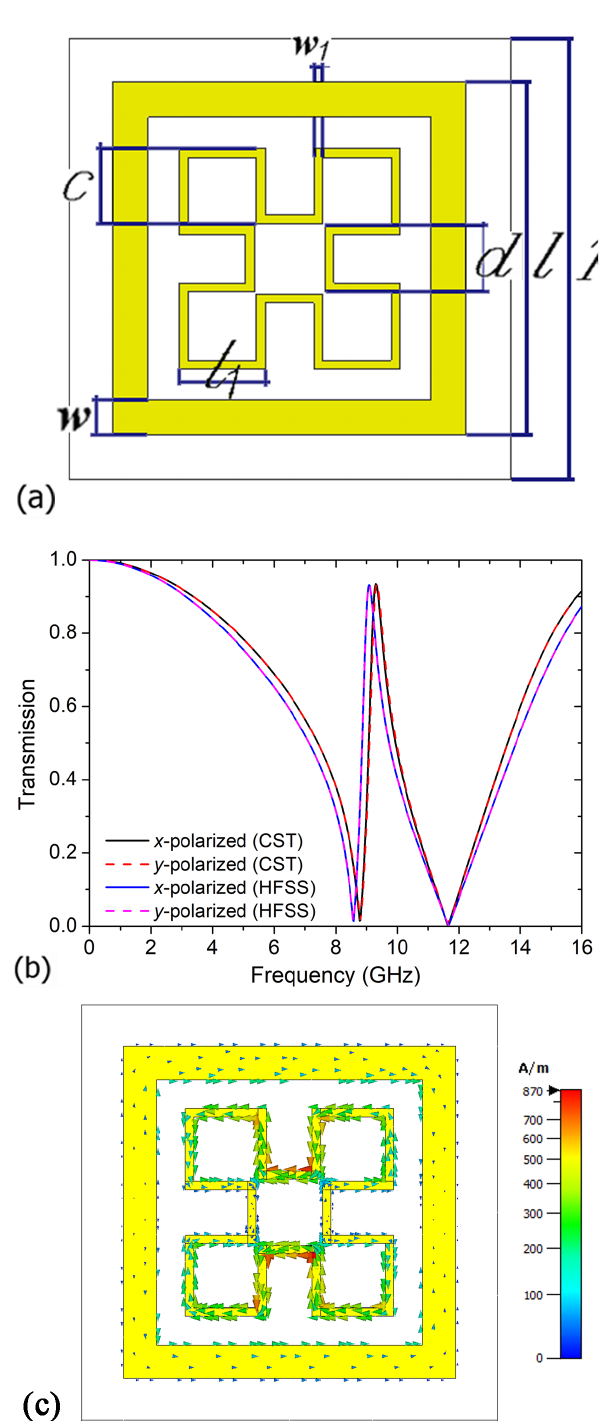
Figure 2: (a) Unit cell, (b) transmission spectra and (c) surface current distributions for the proposed second EIT- like